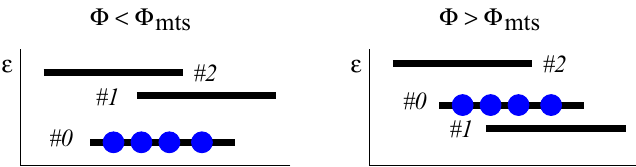
4 particles. The Figure 1. Orbital occupation. For the purpose of illustration we consider a ring with N = orbitals are represented by horizontal lines (the horizontal shifts hints the sign of the momentum). Initially (left panel) the particles are condensed in the #0 momentum orbital. As (cid:31) is increased beyond (cid:31) mts this configuration becomes metastable (right). We ask what is the moment when the #0 orbital is depleted, and what 4 system has 15 energy levels that corresponds to the different is the final distribution of the particles. The N = possibilities to distribute the particles between the orbitals. In the presence of non-zero interaction those levels are partially